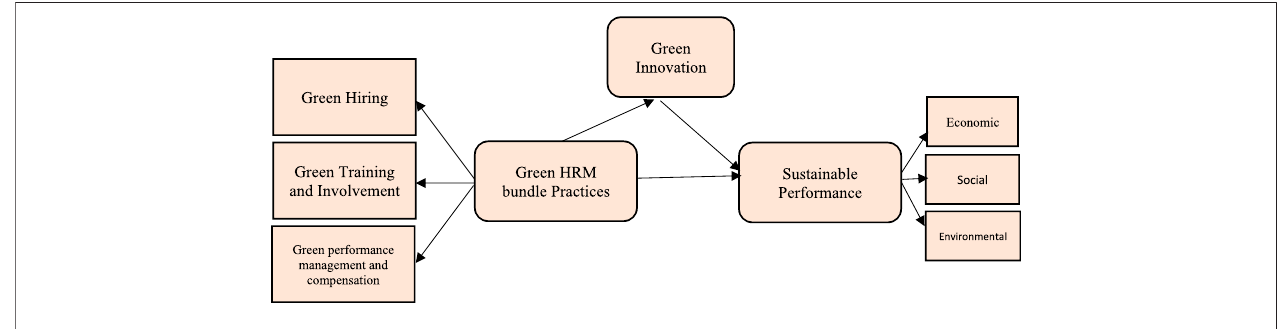
FIGURE 1 | Conceptual